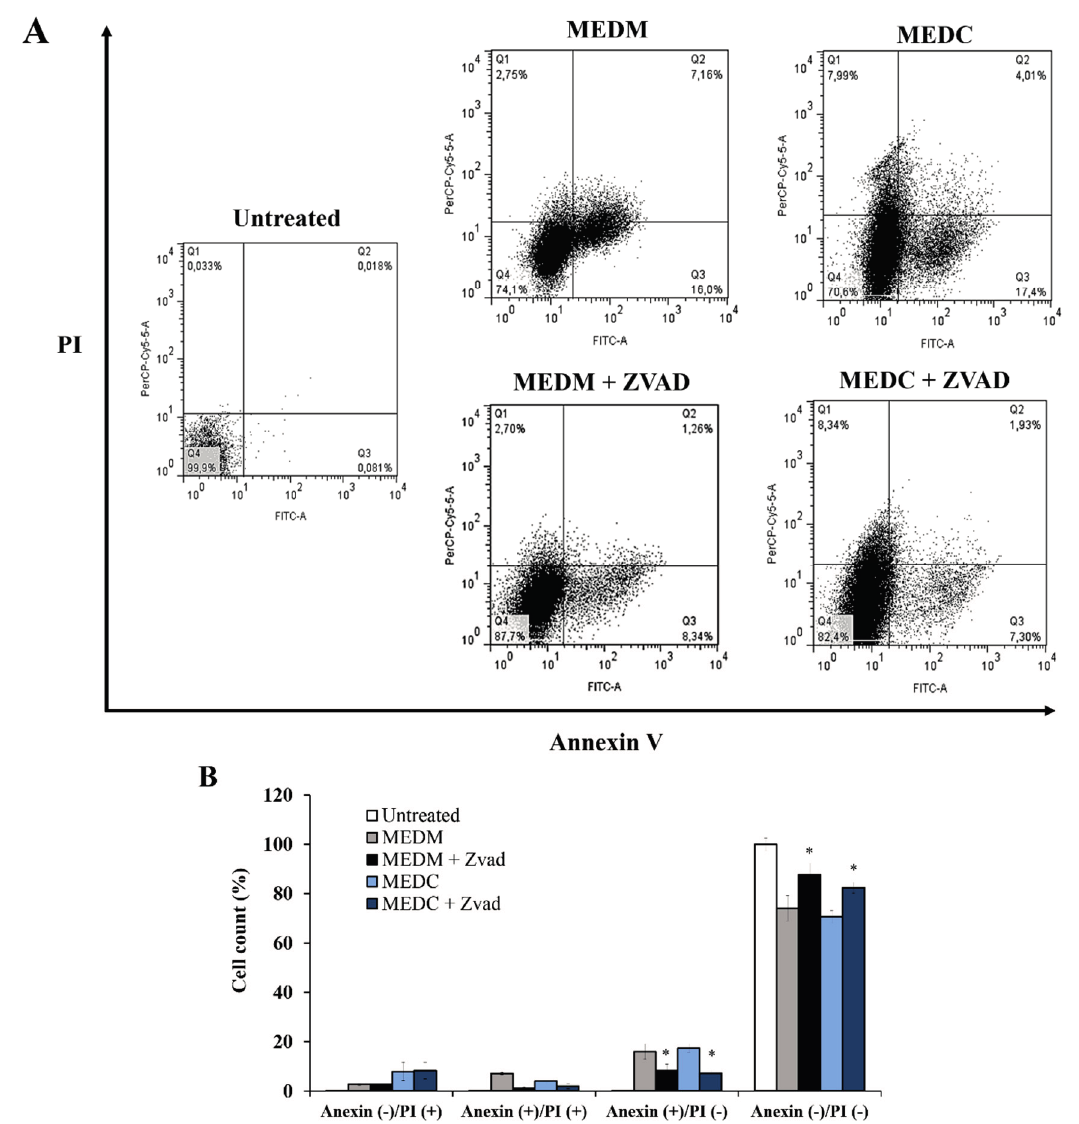
Figure 5. Flow cytometry analysis of HeLa cells after exposure toMEDC and